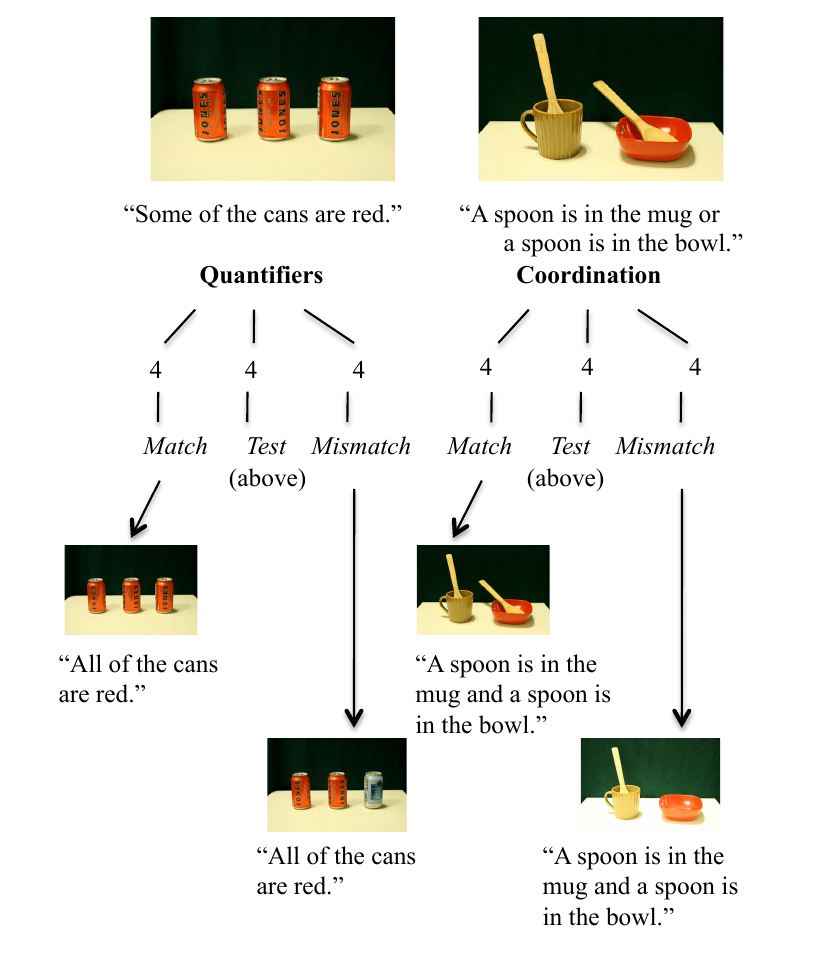
Design of 24 experimental trials, shown in English: 12 Quantifier trials, 12 Coordination